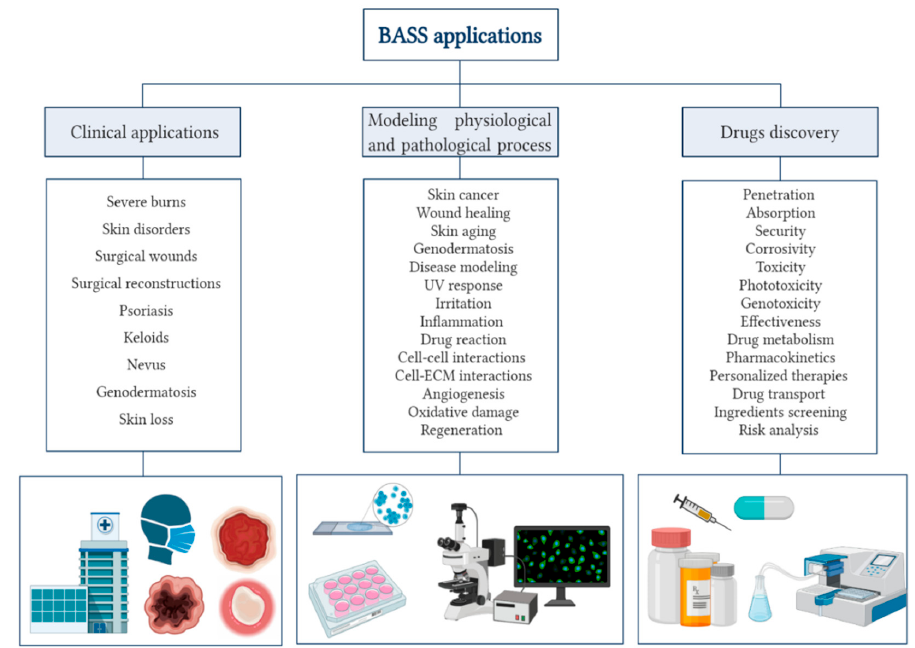
Figure 1. Diagram of the different applications of BASS: clinical applications, modeling physiological and pathological process and drugs discovery. Created with BioRender.com.